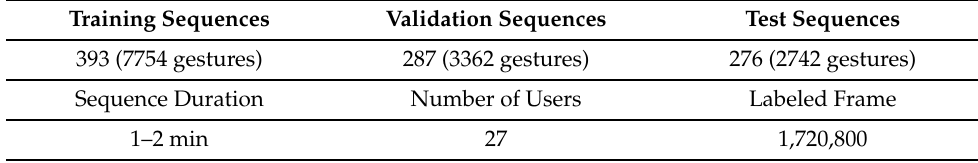
Table 8. Information of Montalbano Gesture